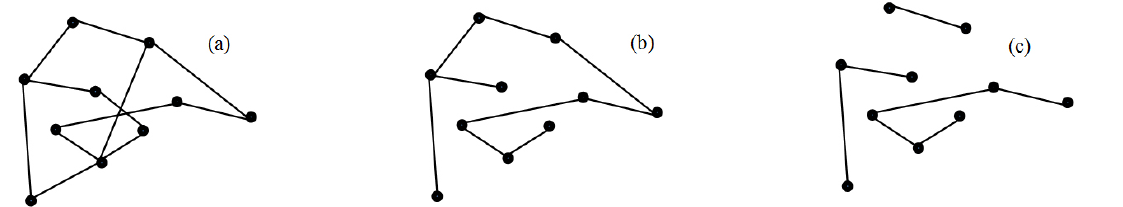
Fig. 1. Networks of arc observations in a SAR interferogram. (a) Network with redundant arcs where there is more than one path to connect some of the point pairs. The rank of them×n matrix A is smaller than m. (b, c) Networks without redundant arcs where there is only one path to connect any two points. The rank of A is equal to